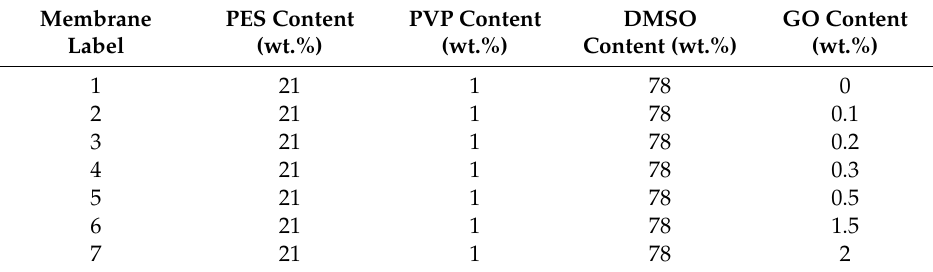
Table 1. The compositions of the casting